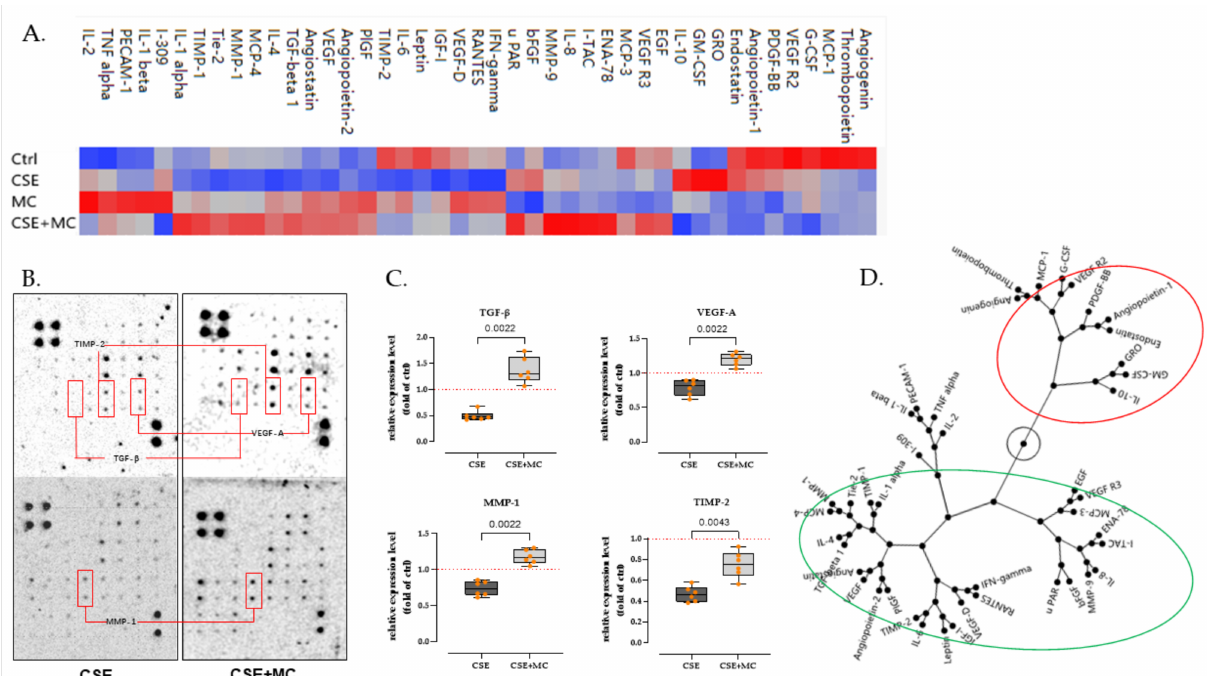
Figure 3. Analysis of angiogenesis-stimulating factors expressed in the supernatant of HaCaT cells after CSE and/or ES exposure. ( A ) The results are presented in a heat map, and the color goes from blue to red with increasing expression values. ( B ) Representative expression of pro-angiogenic factors TGF- β , VEGF-A, MMP-1, and TIPM-2 (shown in red box). ( C ) Data are displayed normalized to the control group’s mean (red dashed line). N = 3 (pooled), n = 2. A non-parametric Mann–Whitney test was used to compare the data. ( D ) The results of the clustering analysis are presented as a constellation diagram. Group 1 (green circles) indicates targets whose expression was impaired by 3% CSE, and 100 µ A MC could prevent this impairment therapeutically. Group 2 (red circles) contains features that differ from Group